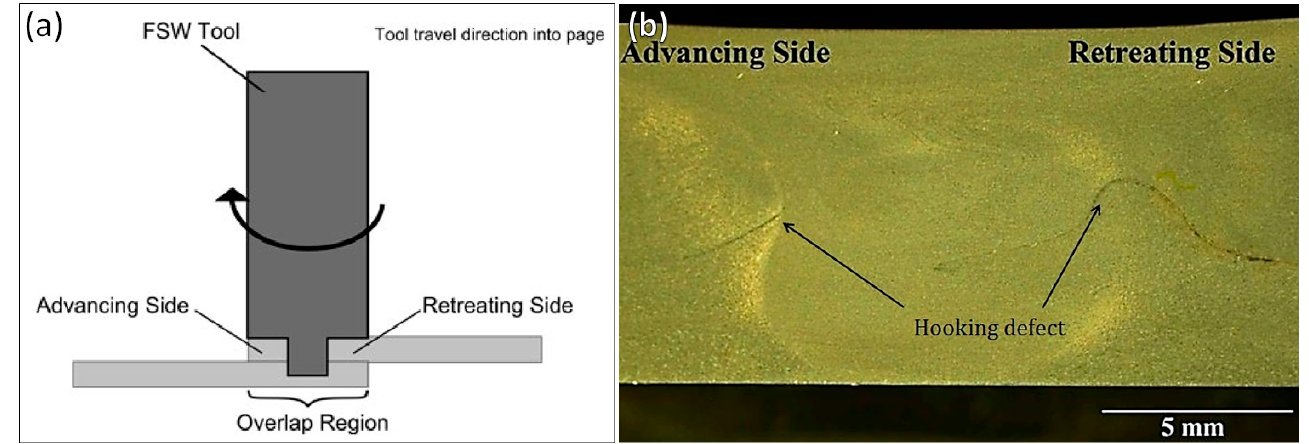
Figure 9. ( a ) Diagram of FSLW [124] ( b ) Hooking defects on the advancing and retreating sides in lap welds between 5 mm-thick AA5456-H321 and 2.5 mm-thick AA5456-O [127]. Figure 9a reprinted from: Seam-tracking for friction stir welded lap joints. Journal of materials engineering and performance 19 (2010): 1128–1132, Fleming, Paul A., Christopher E. Hendricks, George E. Cook, D. M. Wilkes, Alvin M. Strauss, and David H. Lammlein, Copyright 2010, with permission from Springer Nature. Figure 9b reprinted from: Effect of process parameters on the macrostructure and defect formation in friction stir lap welding of AA5456 aluminum alloy. Measurement 76 (2015): 62–69, Shirazi, H., S. H. Kheirandish, and M. A. Safarkhanian, Copyright 2015, with permission from Elsevier.